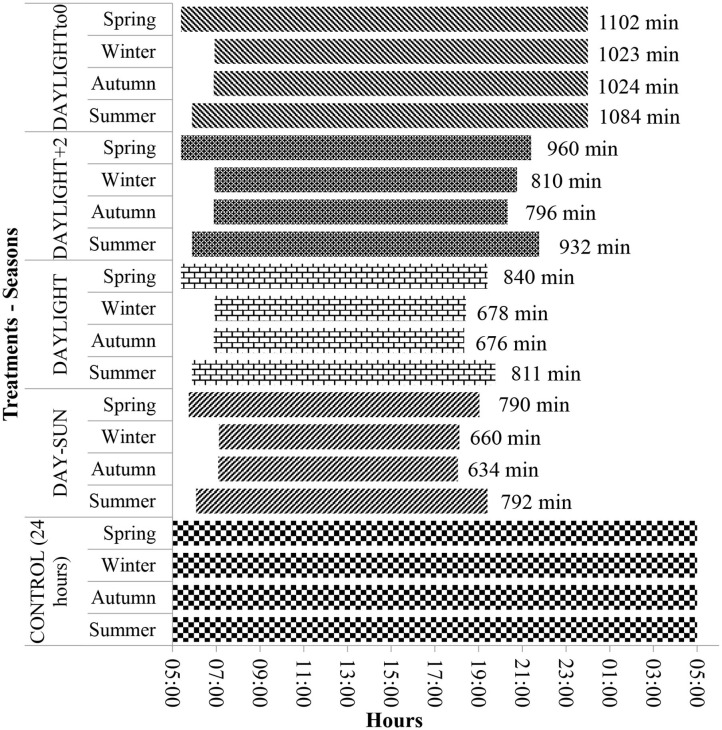
Graphical timeline representation of the timing and duration of evaluations of grazing behavior in 24 h (control; 1,440 min assessment) and the tested periods of time (treatments): DAY-SUN (sunrise to sunset), DAYLIGHT (down to nightfall), DAYLIGHT+2 (down to nightfall plus 2 h after dark), and MIDNIGHT to 0 (down until midnight).